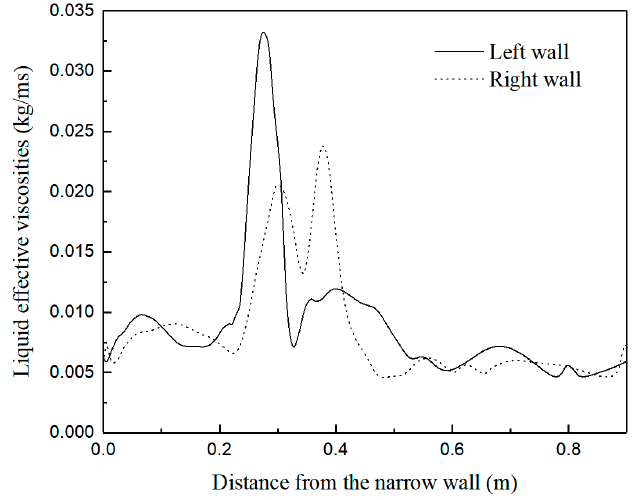
Figure 19. Effective viscosity of the turbulent flow along the centerline at both sides of the mold at the mirror stage.